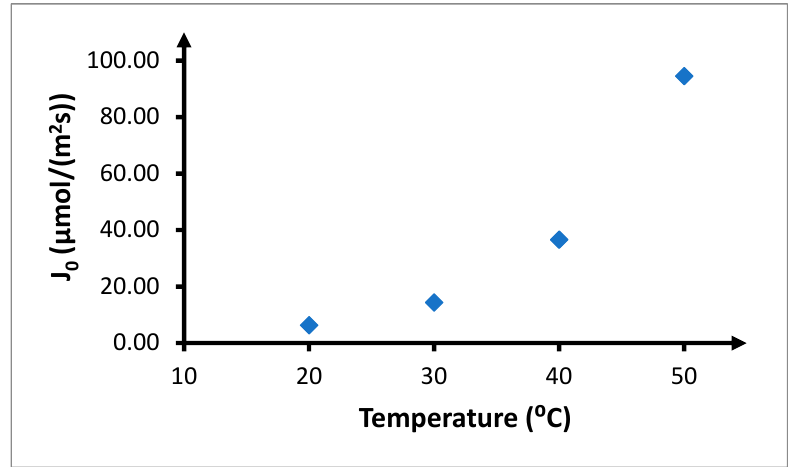
Figure 12. E ff ect of temperature on the initial flux of copper(II) ions. The volumetric flow rate is 3.0 cm 3 / min. Feeding phase: CuCl 2 concentration—0.1 mol / dm 3 , chloride concentration—2.0 mol / dm 3 . Receiving phase: demineralized water. Membrane: CTA-ONPOE-TRIA-10. The composition of the membrane is provided in Table